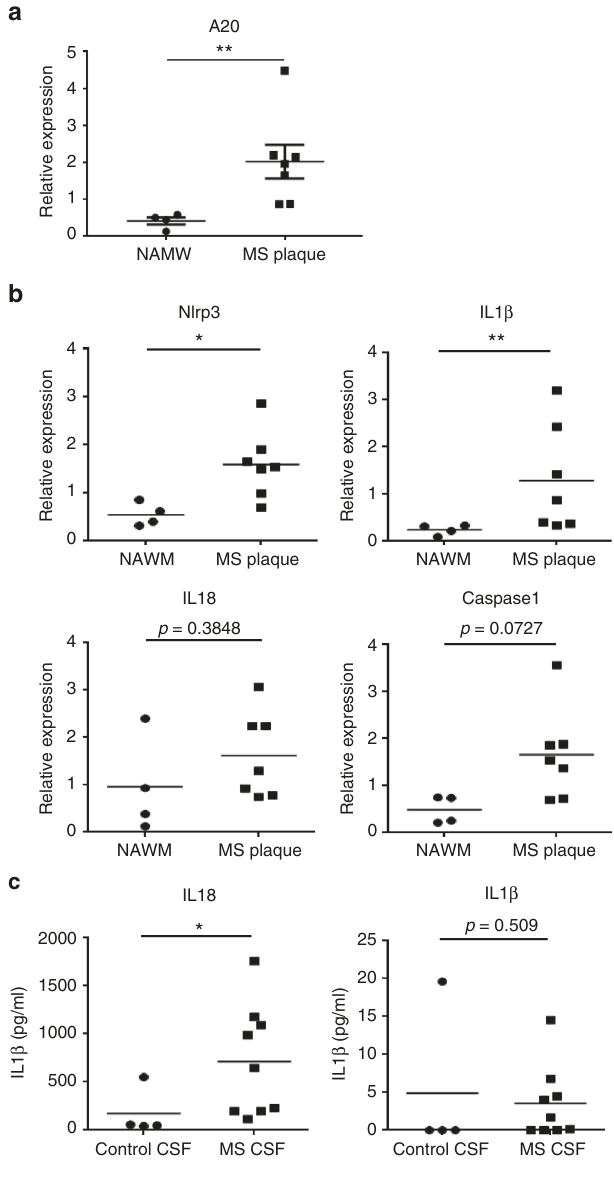
Fig. 6 Enhanced A20 expression and NLRP3 in fl ammasome activation in human MS samples. a , b Relative gene expression levels of A20/ TNFAIP3 ( a ) and of in fl ammasome-associated factors ( b ) in plaques of postmortem MS patients (plaque) or postmortem control tissue (NAWM). Each symbol represents one patient. Data are expressed as the ratio of the mRNA expression normalized to endogenous housekeeping genes ( Sdha and Tbp ) and expressed as mean ± SEM. Signi fi cant differences are determined by Mann – Whitney U -statistical test (* p < 0.05, ** p < 0.01). c IL-1 β and IL-18 cytokine levels in the CSF of postmortem MS patients or control samples. Each symbol represents one CSF sample. Signi fi cant differences are determined by Mann – Whitney U -statistical test (* p <